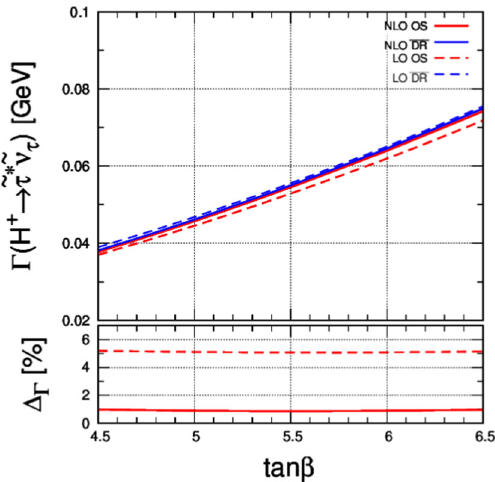
Fig. 11 Thepartialdecaywidthforthedecaysintostau-sneutrinopairs as a function of tan β for OS (red) and DR (blue) renormalization at LO (dashed) and NLO (full). Lower insert: The relative difference in the widths due to different renormalization schemes at LO (dashed) and NLO